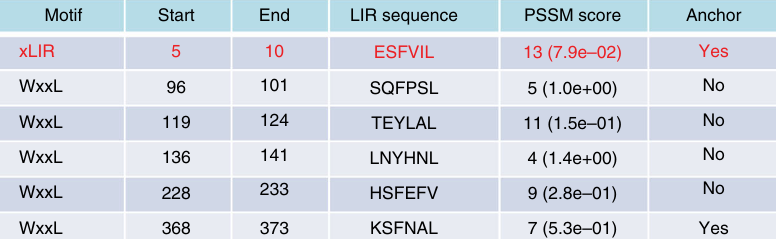
Fig. 1 Kenny is a UBAN domain-containing protein with a xLIR motif. Screenshot of the result window from the iLIR server (http://ilir.warwick.ac.uk/) for the protein sequence of Kenny (UniProt Q9GYV5). xLIR: relaxed LIR motif; WxxL: conventional LIR motif; CC: coiled coil; UBAN: ubiquitin binding in ABIN and NEMO domain; ZnF: Zinc fi nger motif; PSSM: position-speci fi c scoring